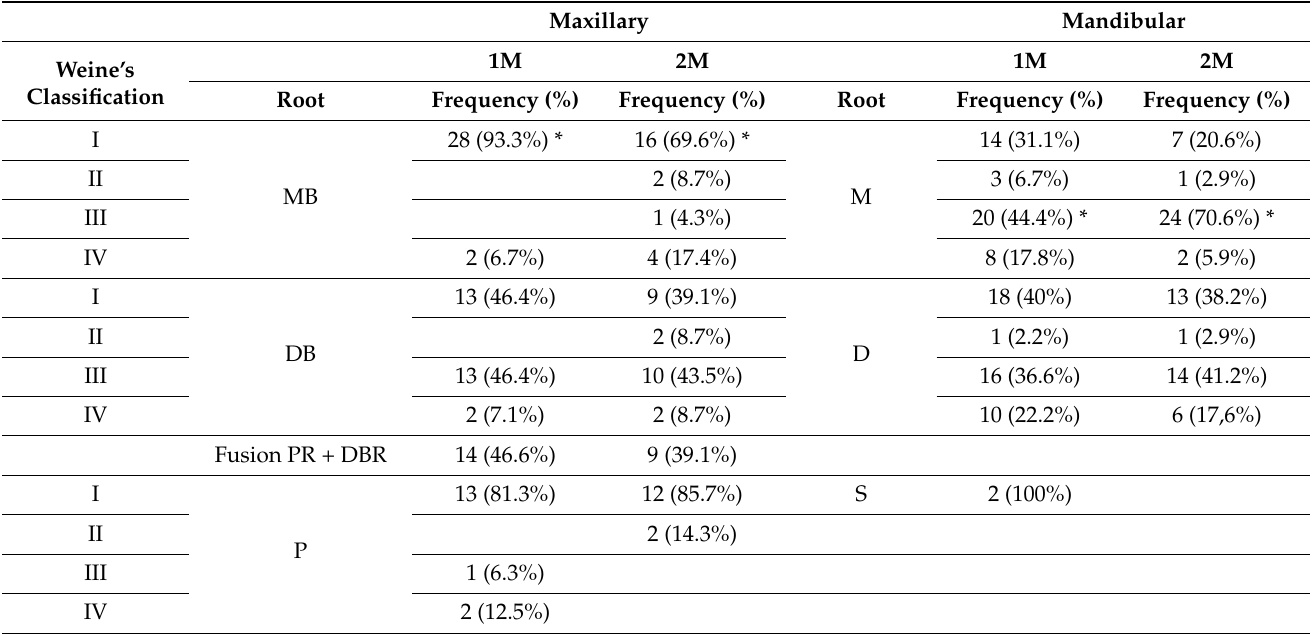
Table 1. Root morphology distribution of deciduous molars.